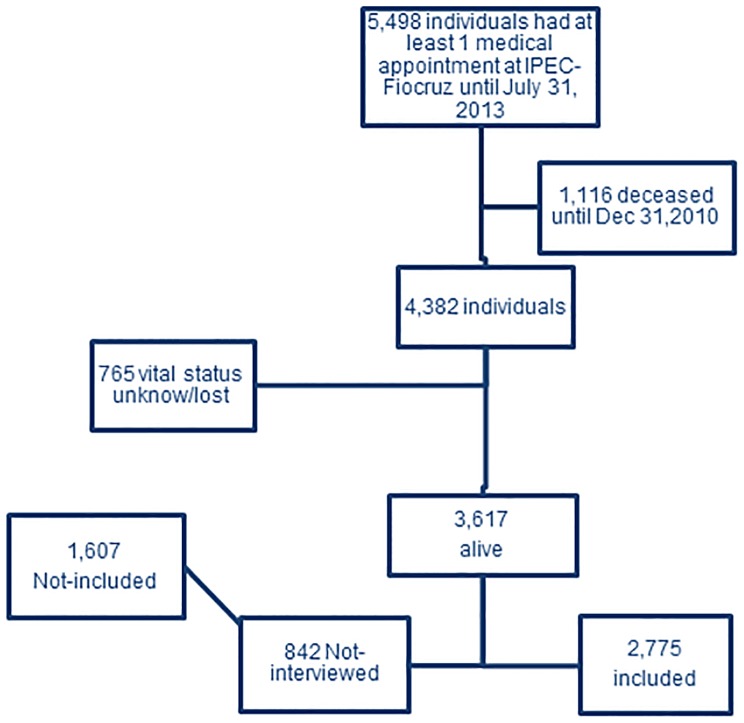
Study Population.